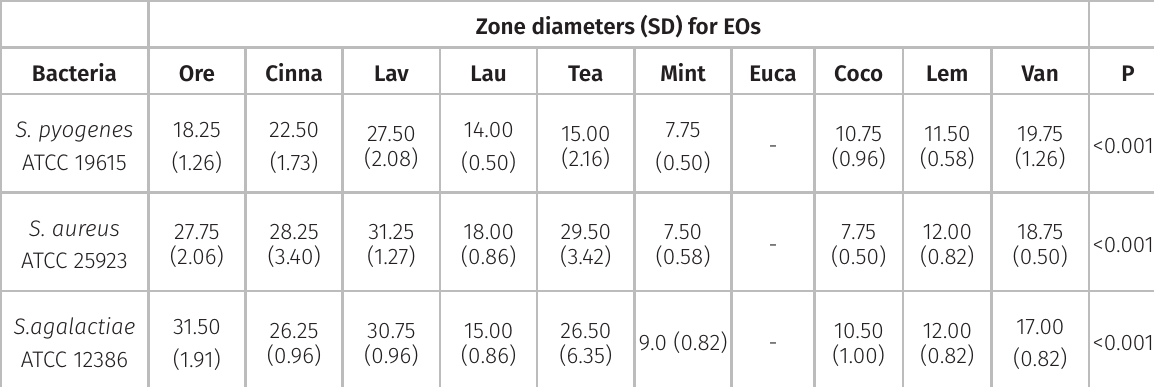
Table II. Mean, Standard Deviation and Range of Zone Diameters (mm) for EOs against S. pyogenes , S. aureus and S. agalactiae.